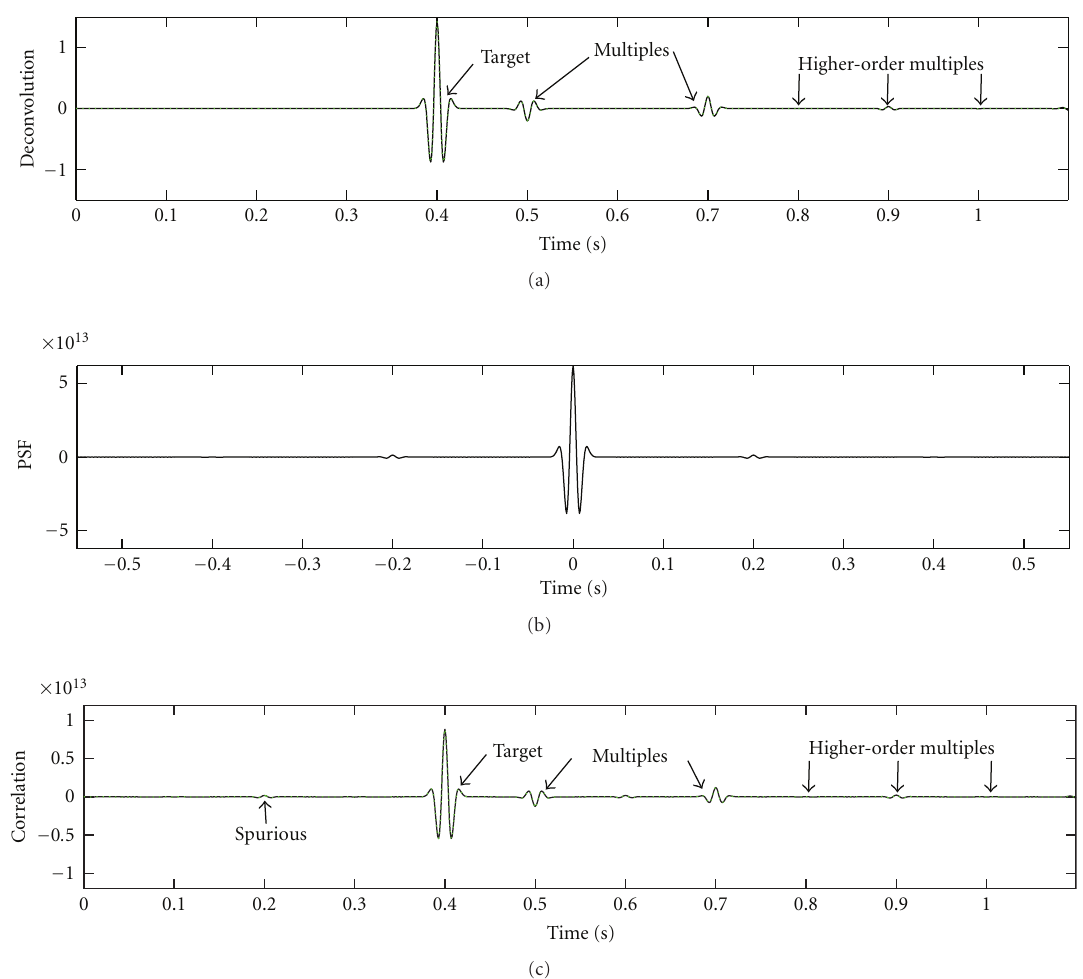
Figure 14: Deconvolution of perturbed fields for model B: (a) retrieved Green’s function (black) and the reference response (dashed green); (b) point spread function Γ ptb ; (c) convolution of the reflection response with the PSF (black) and correlation function C ptb (dashed